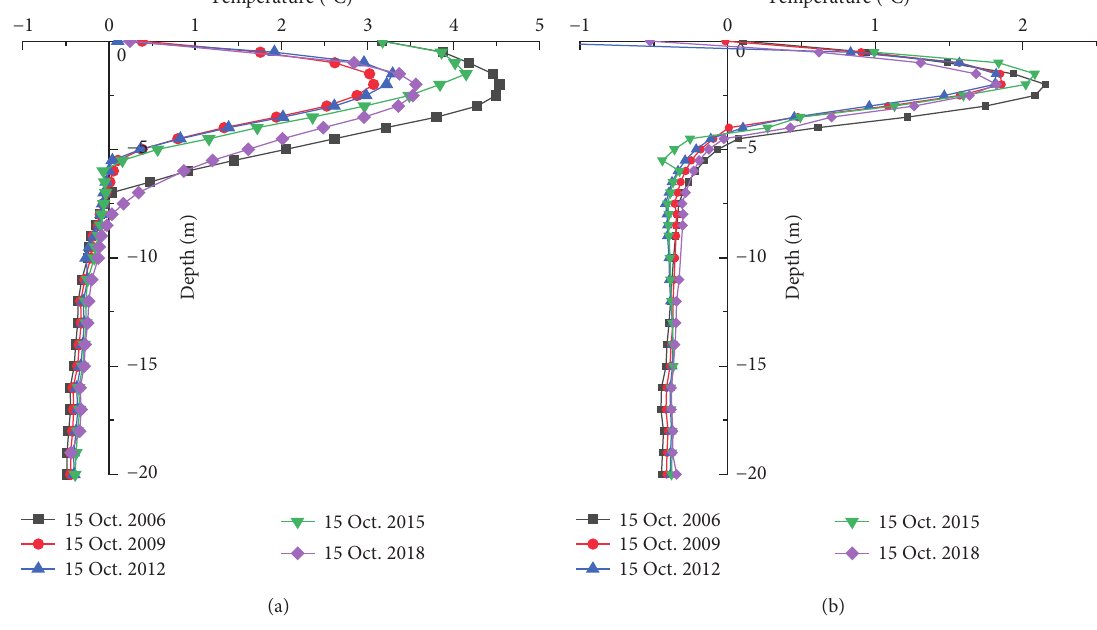
Figure 5: Ground temperature profiles on Oct. 15th at the sunny shoulder (a) and the shady shoulder (b) in different years.